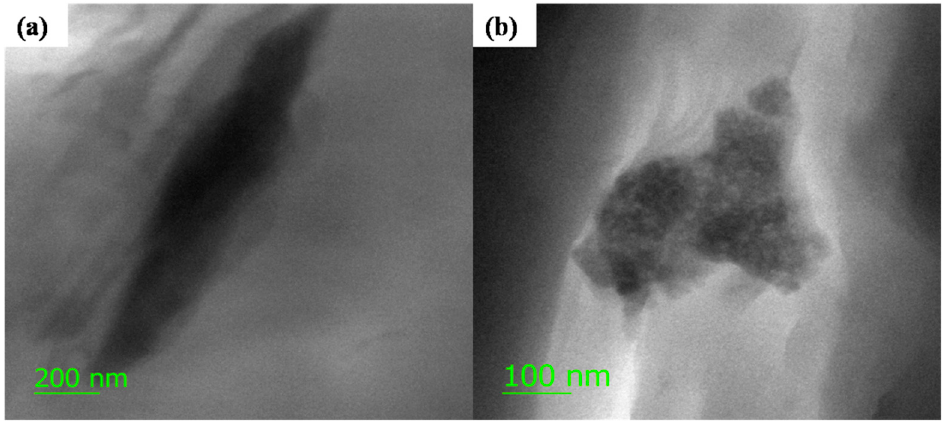
Figure 7. TEM micrograph of ( a , b ) CTAB–MoS 2 /LLDPE composite with 2 wt %CTAB–MoS 2 .